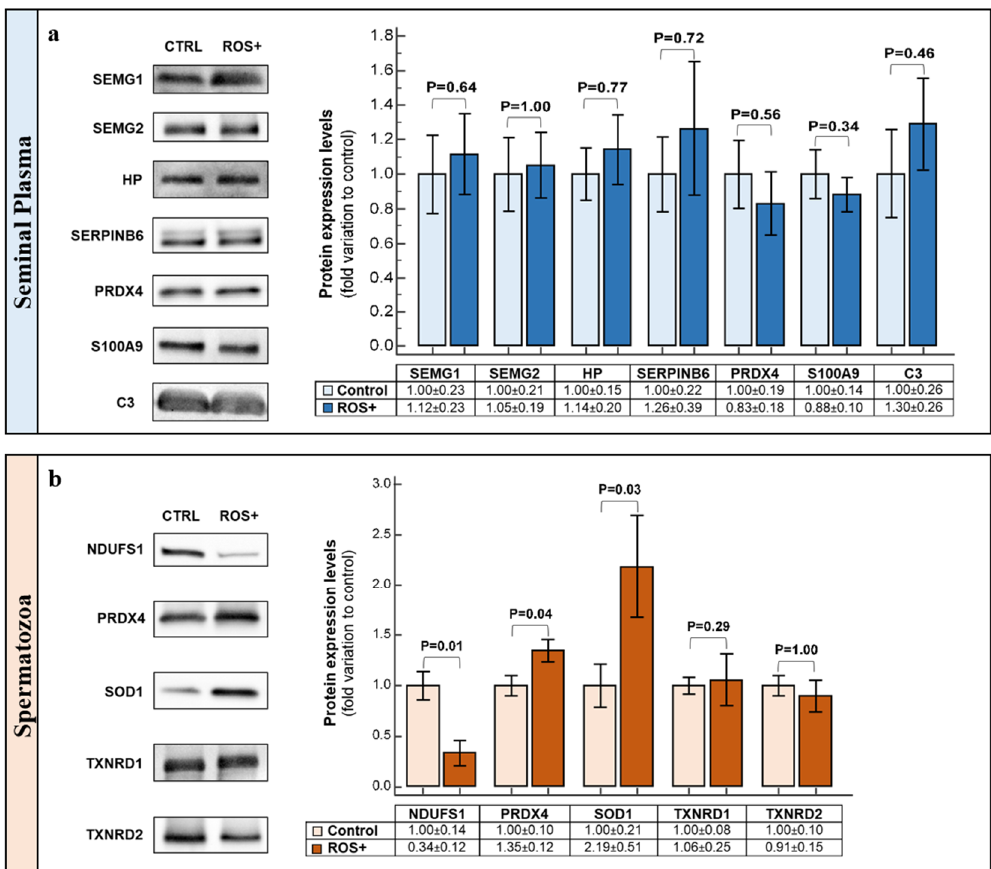
Figure 3. Graphical representation of Western blot results and respective representative blots for: ( a ) seminal plasma; and ( b ) spermatozoa proteins. Results are expressed as mean ± SEM and were considered significant for p < 0.05.